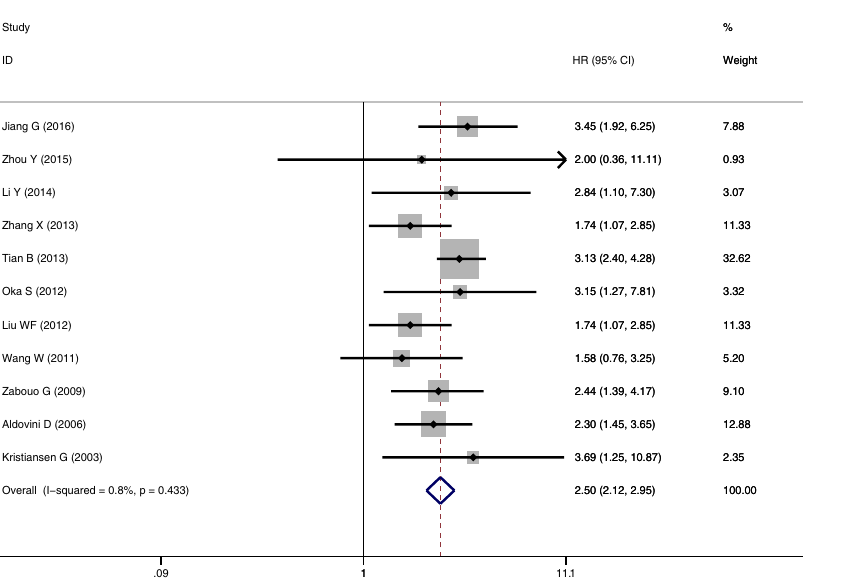
CD146 expression and solid cancer prognosis by meta-analysis. Pooled HRs and 95% CIs for these outcome endpoints (OS, TTP) were calculated. Subgroup analysis was performed when there were at least three studies in each subgroup. Statistical heterogeneity was assessed using the Q test, and a P value > 0.10 suggested a lack of heterogeneity among studies. We also quantified the effect of heterogeneity using I 2 = 100% × (Q − df)/Q. I 2 values of < 25% may be considered “low”, values of about 50% may be considered “moderate” and values of > 75% may be considered “high” 33 . According to the absence or presence of heterogeneity, random effects model or fixed effects model was used to merge the HR, respectively. Without statistical heterogeneity, a fixed effects model was employed to calculate the pooled HRs, otherwise random effects model was used 34 . Funnel plots and the Egger’s test were used to estimate the possible publication bias 35 . If a publication bias did exist, the Duval and Tweedie’s trim and fill method was then used to assess its influence on the overall effect 36 . Sensitivity analysis was also con- ducted to find out if certain individual article could influence the overall result. The Stata 14.0 (StataCorp, College Station, TX) was used to conduct statistical analyses. P values for all comparisons were two-tailed and statistical significance was defined as p < 0.05 for all tests, except those for heterogeneity.